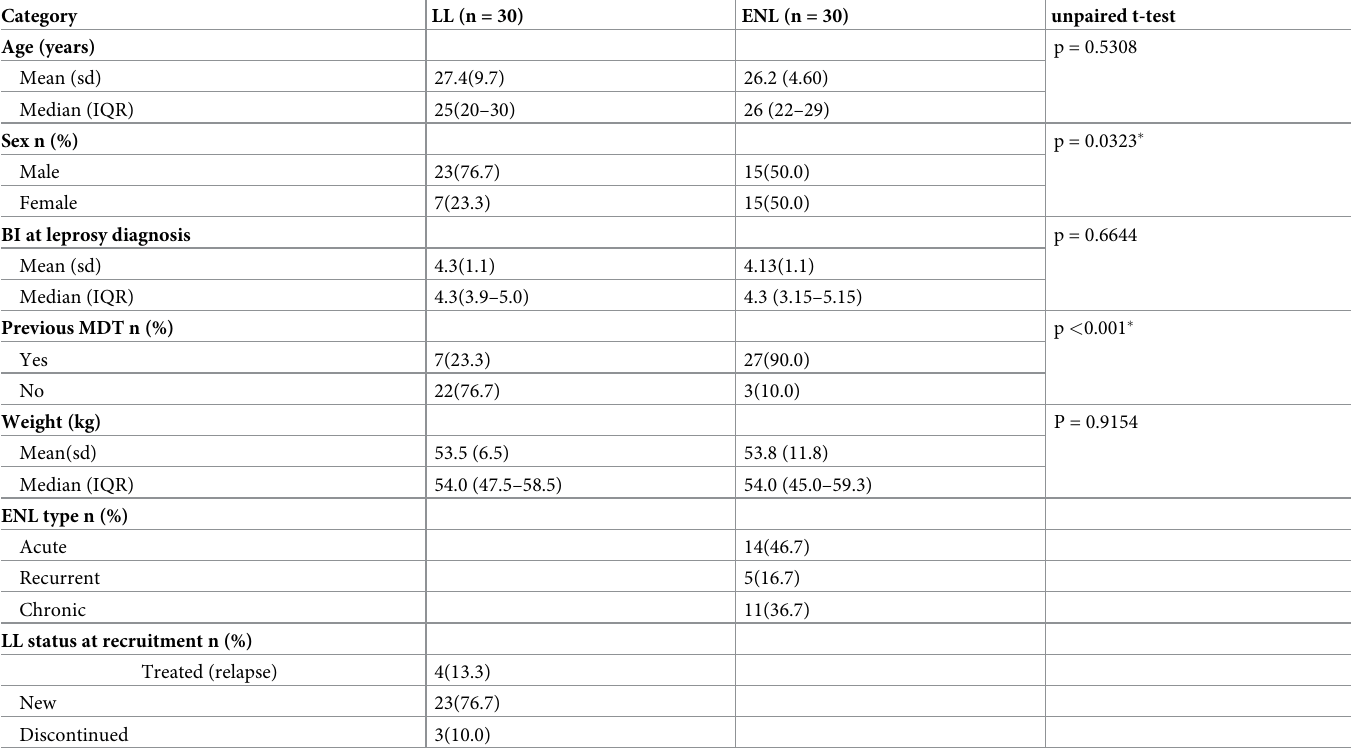
Table 1. Demographic characteristics of study